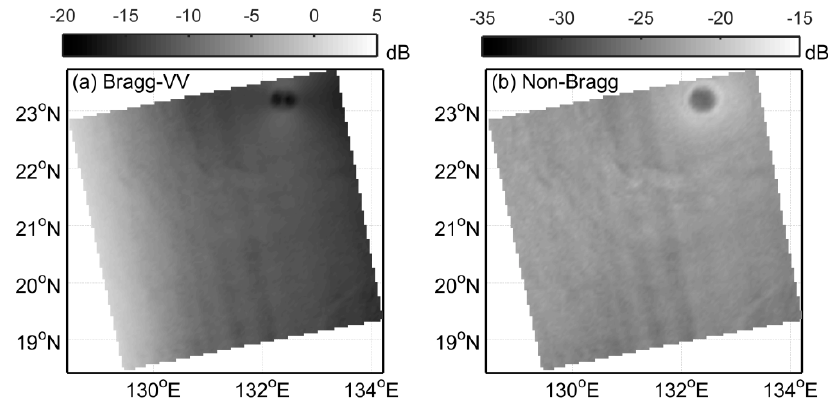
Figure 6. ( a ) Simulated VV-polarized NRCS by the two-scale Bragg model. ( b ) Simulated Non-Bragg scattering NRCS.